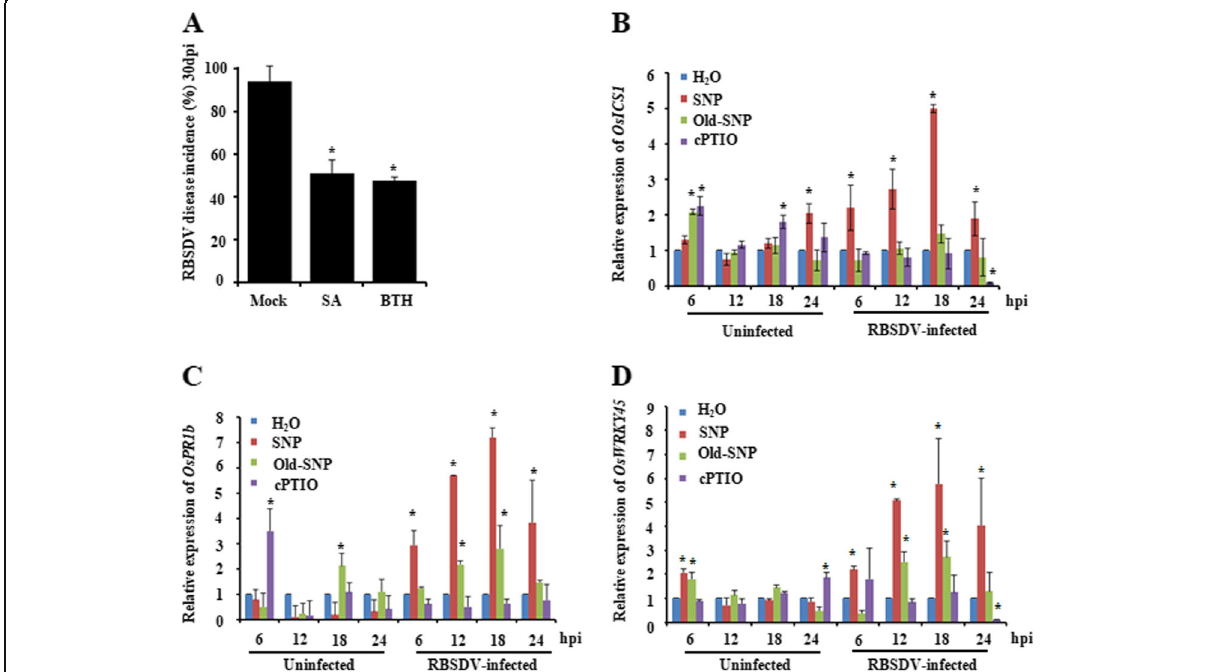
Fig. 4 Changes in SA and defense responsive genes. a RBSDV disease incidence of the 500 μ M SA- or 500 μ M BTH pre-treated Nipponbare rice. 30 two-leaf stage rice seedlings of each cultivar were tests for disease incidence experiment. Images are representative of three independent biological experiments. The data represented the means ± SD of the three replicates. b to d Expressions of OsICS1 , OsPR1b and OsWRKY 45 in the SNP-, old SNP- or cPTIO-treated RBSDV-inoculated plants determined by qRT-PCR. Expressions of OsUBC and OsActin1 in the rice plants were used as internal controls. The expression levels of OsICS1 , OsPR1b and OsWRKY 45 in the water-treated RBSDV-inoculated plants were set as 1.0. Five plants were pooled together as one biological experiment. The data represented the means ± SD of the three biological replicates. Entire experiment repeated 3 times with similar results. Statistical differences between treatments in each time point were determined by the Duncan ’ s multiple test, p